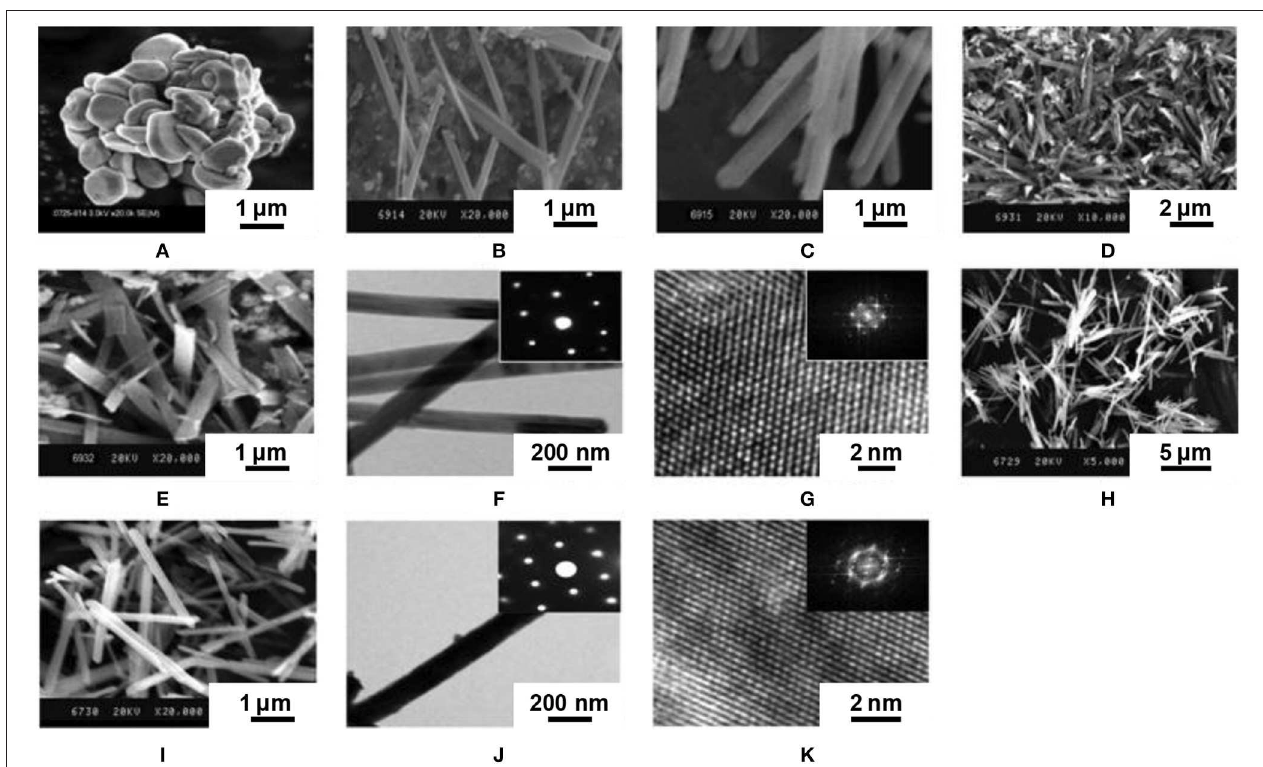
FIGURE 9 | Europium-doped yttrium oxysulfide nanoparticles with different morphologies obtained via the composite-hydroxide-mediated method and their precursors. (A) SEM image of bulk Y 2 O 2 S:Eu. (B) SEM image of Y(OH) 3 nanobelts. (C) SEM image of Y(OH) 3 nanorods. (D) SEM image of Y 2 O 2 S:Eu nanobelts. (E) SEM image of Y 2 O 2 S:Eu nanorods. (F) TEM and (G) HRTEM images of Y 2 O 2 S:Eu nanobelts. (H) High-magnification SEM image of Y 2 O 2 S:Eu nanobelts. (I) High-magnification SEM image of Y 2 O 2 S:Eu nanorods. (J) TEM and (K) HRTEM images of Y 2 O 2 S:Eu nanorods. Insets are corresponding SAED patterns. Adapted from Thirumalai et al. (2011a), copyright (2011) The Institution of Engineering and Technology.